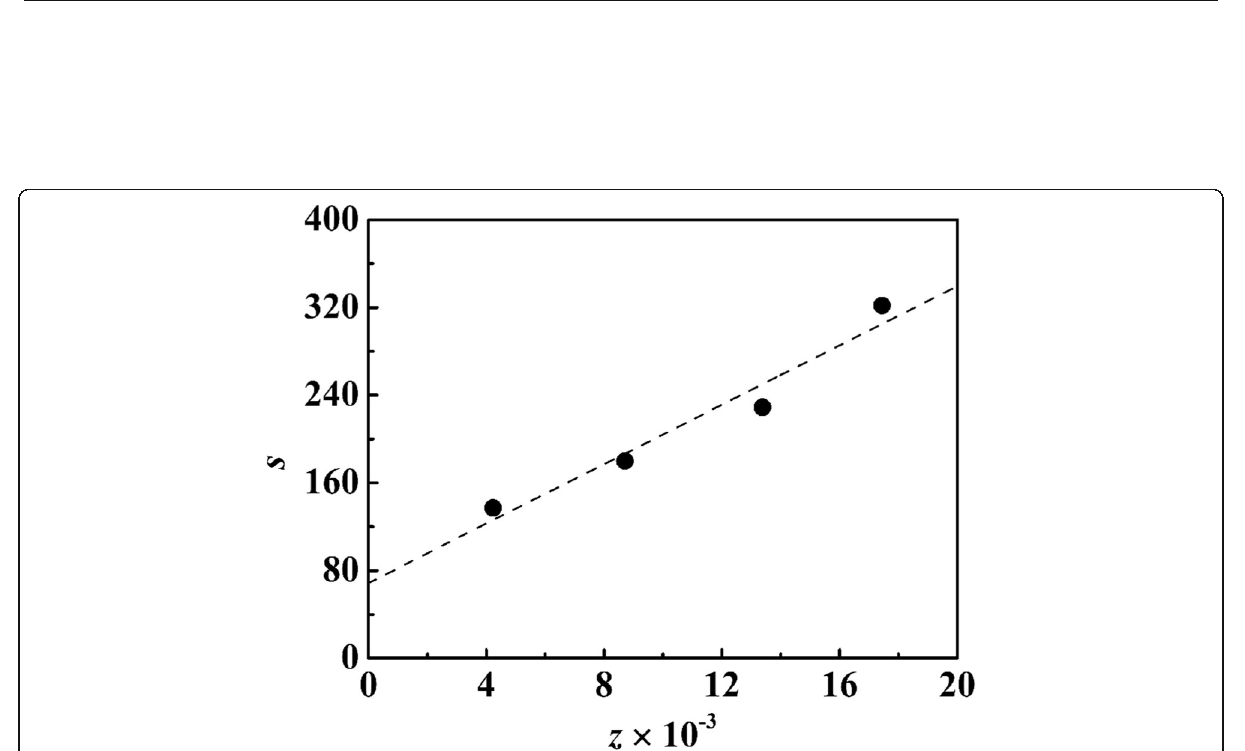
Fig. 8 Variation of the amount of silver nanoparticles with number of − COO + per